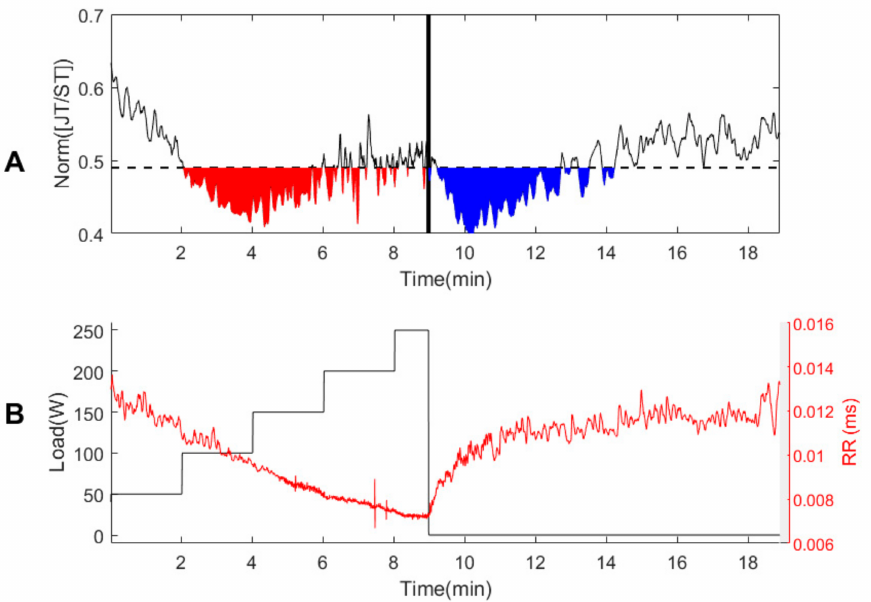
Figure 4. The dynamics of the JT/ST relationship during the load and recovery processes for person #3. The x -axis in parts ( A , B ) represents the time (measured in minutes) from the beginning of the cycle ergometry exercise. The left y-axis in part ( B ) represents the power of the load in Watts. The right y-axis in part ( B ) represents the variation of the RR interval in ms. The algebraic JT/ST relationship is represented by the thin dashed black line in part A. The thick black solid vertical line in part A marks the end of the